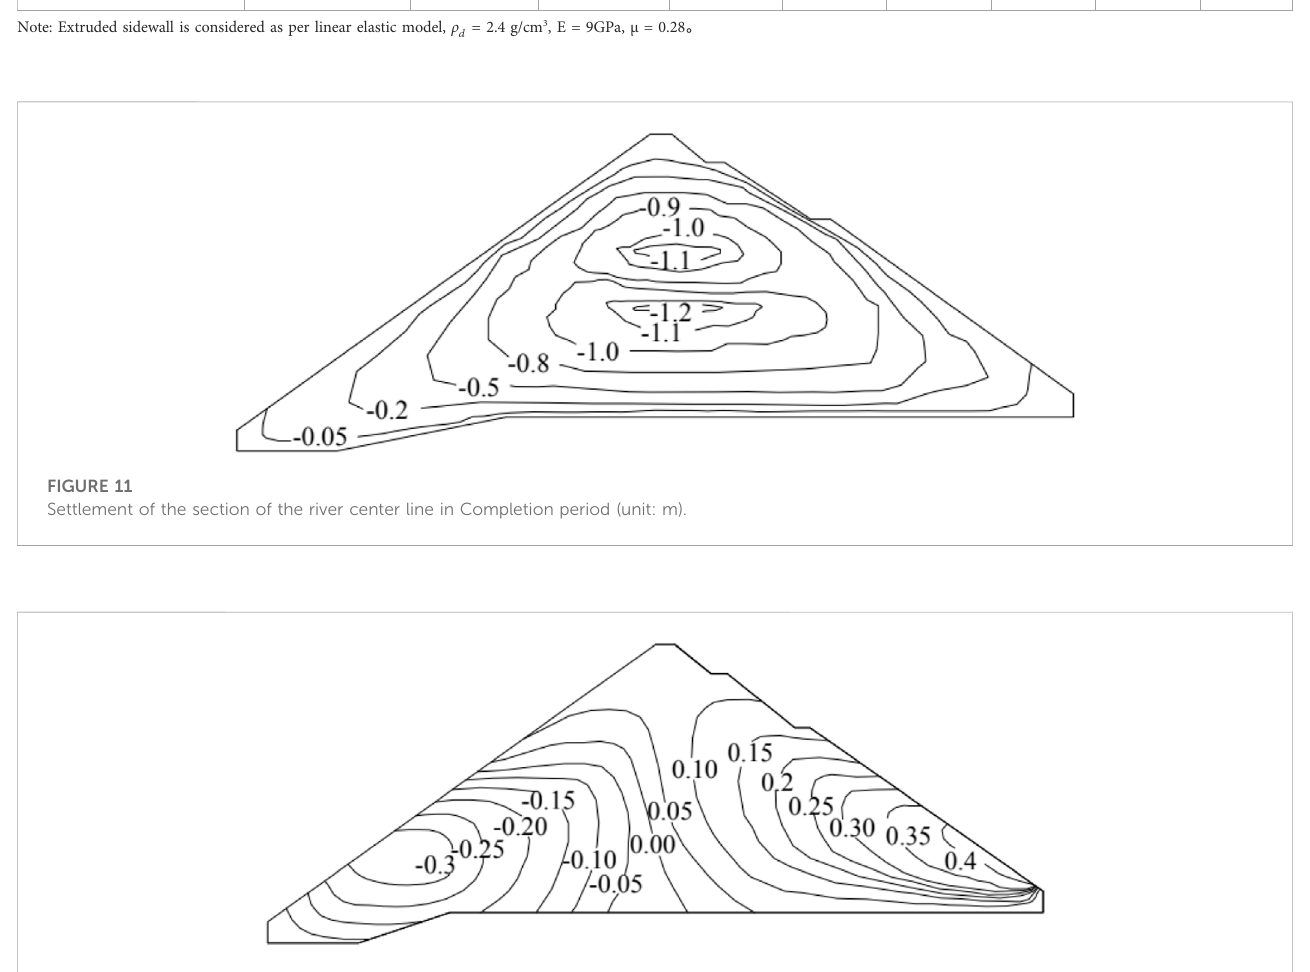
FIGURE 12 Horizontal deformation of the section of river center line in Completion period (unit: